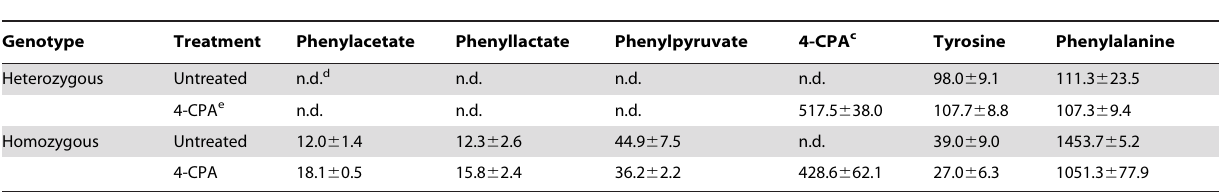
Table 2. Amino Acid and Phenylketone Levels in Plasma of Treated Mice a,b